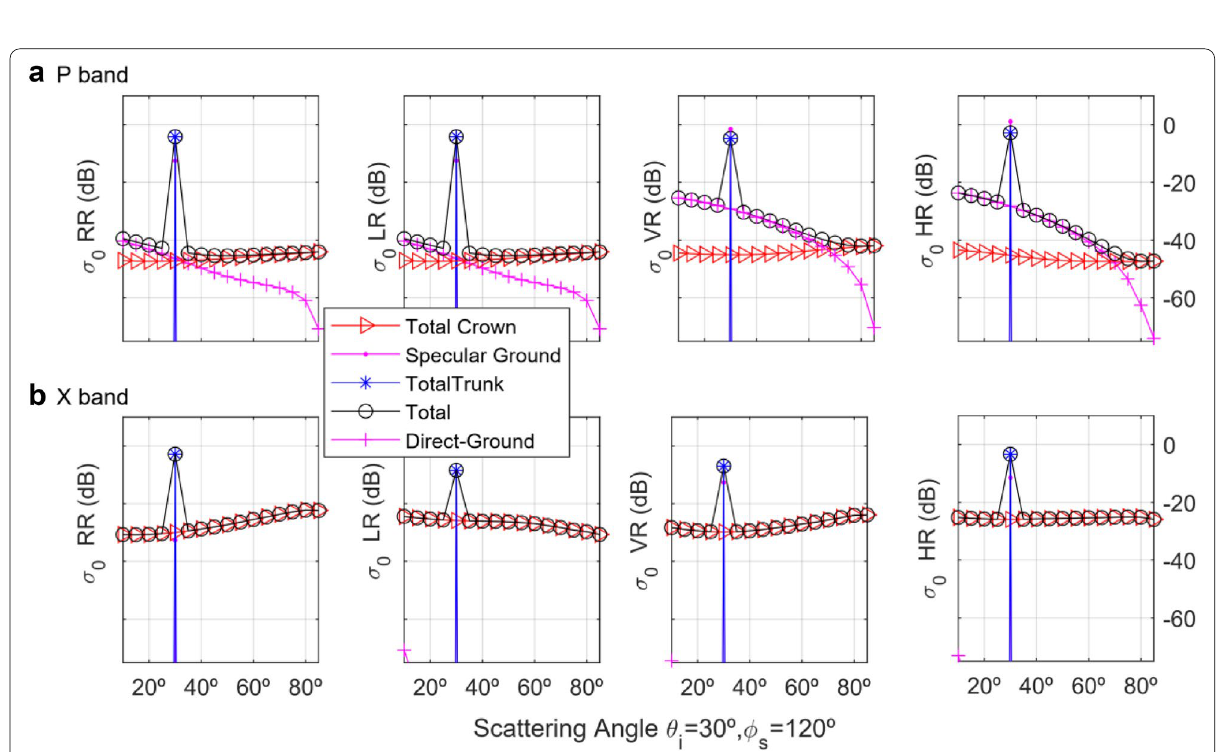
Fig. 6 a P and b X-band canopy scattering contributions versus scattering angle from aspen at θ i